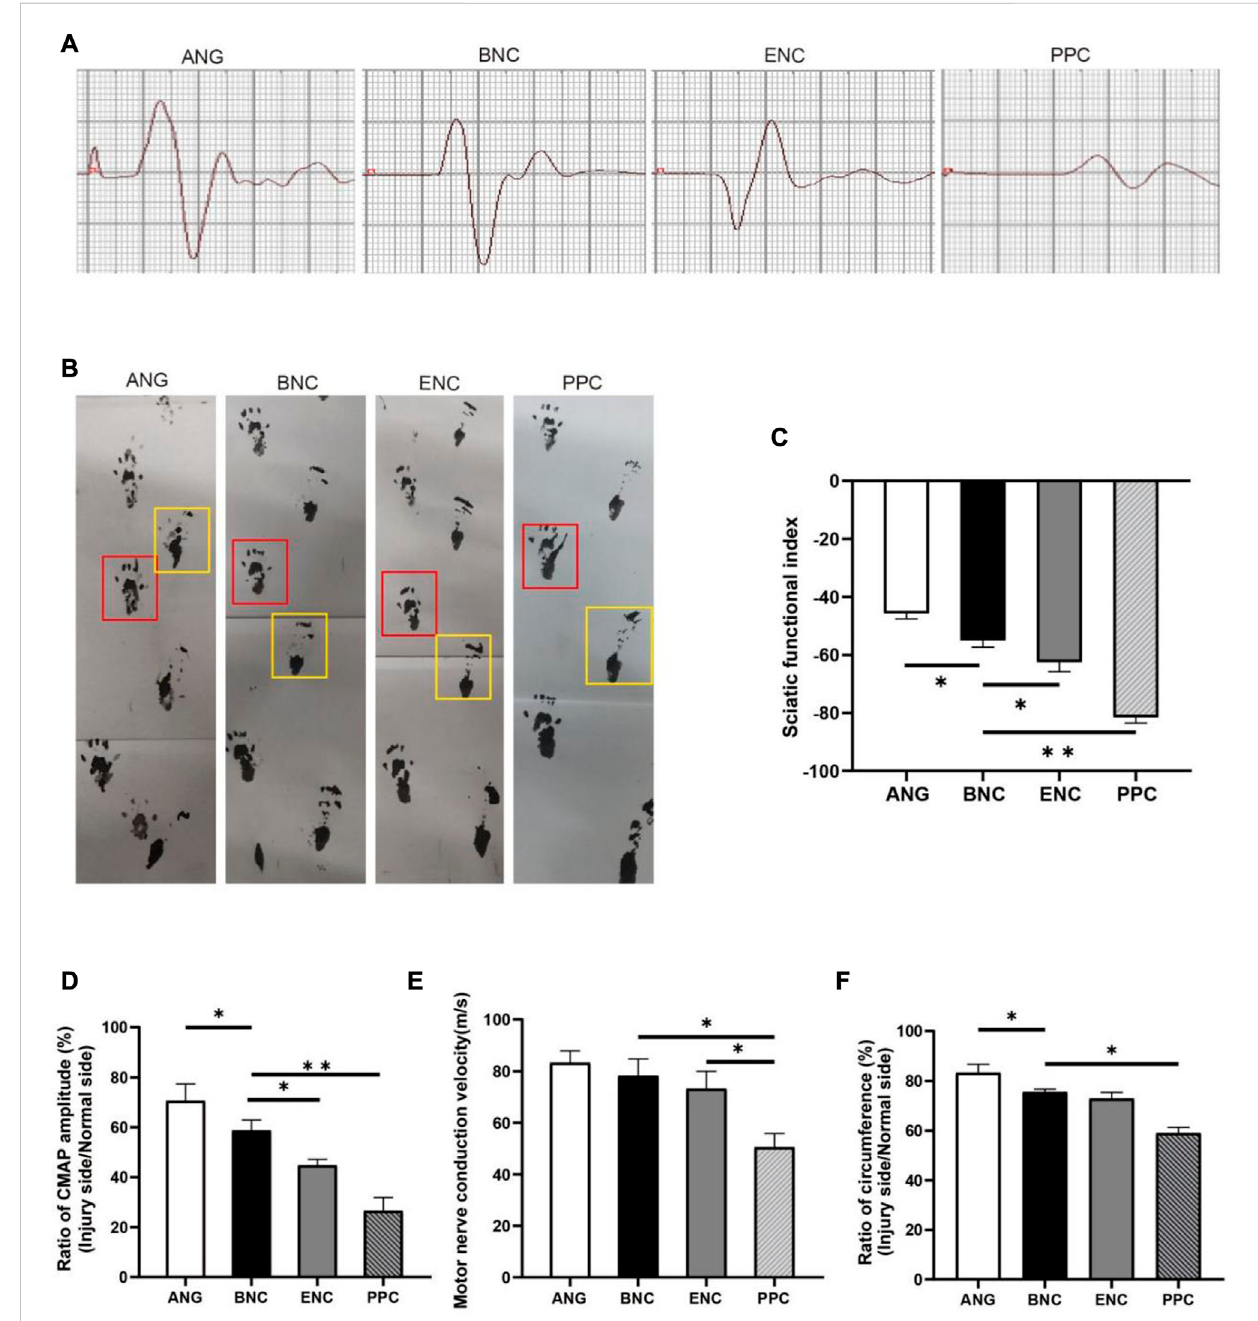
FIGURE 7 TheevaluationofelectrophysiologyandSFIvaluesofregeneratednerves. (A) RepresentativeCMAPrecordingsattheinjurysite. (B) Footprintanalysis in each group (the yellow box represents the injured side; the red box represents the normal side). The histograms show SFI value (C) , ratio of CAMP amplitude (D) , MCV (E) and, ratio of circumference (F) at 12 weeks after surgery. Data are expressed as the mean ± SD ( n = 5) (* p < 0.05, ** p <